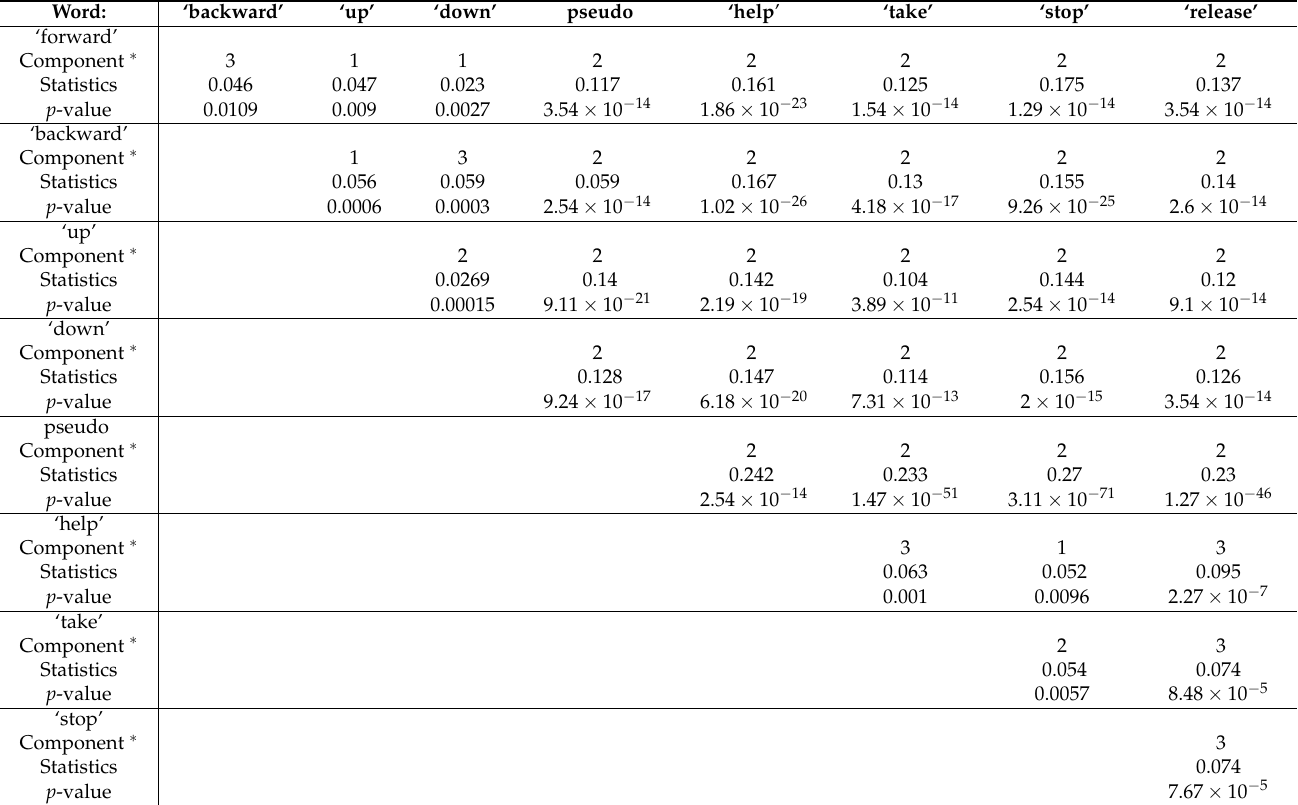
Table 3. Kolmogorov–Smirnov test. Statistics and p -value (statistically significant differences) for the distributions of EEG-data corresponding to different words in silent